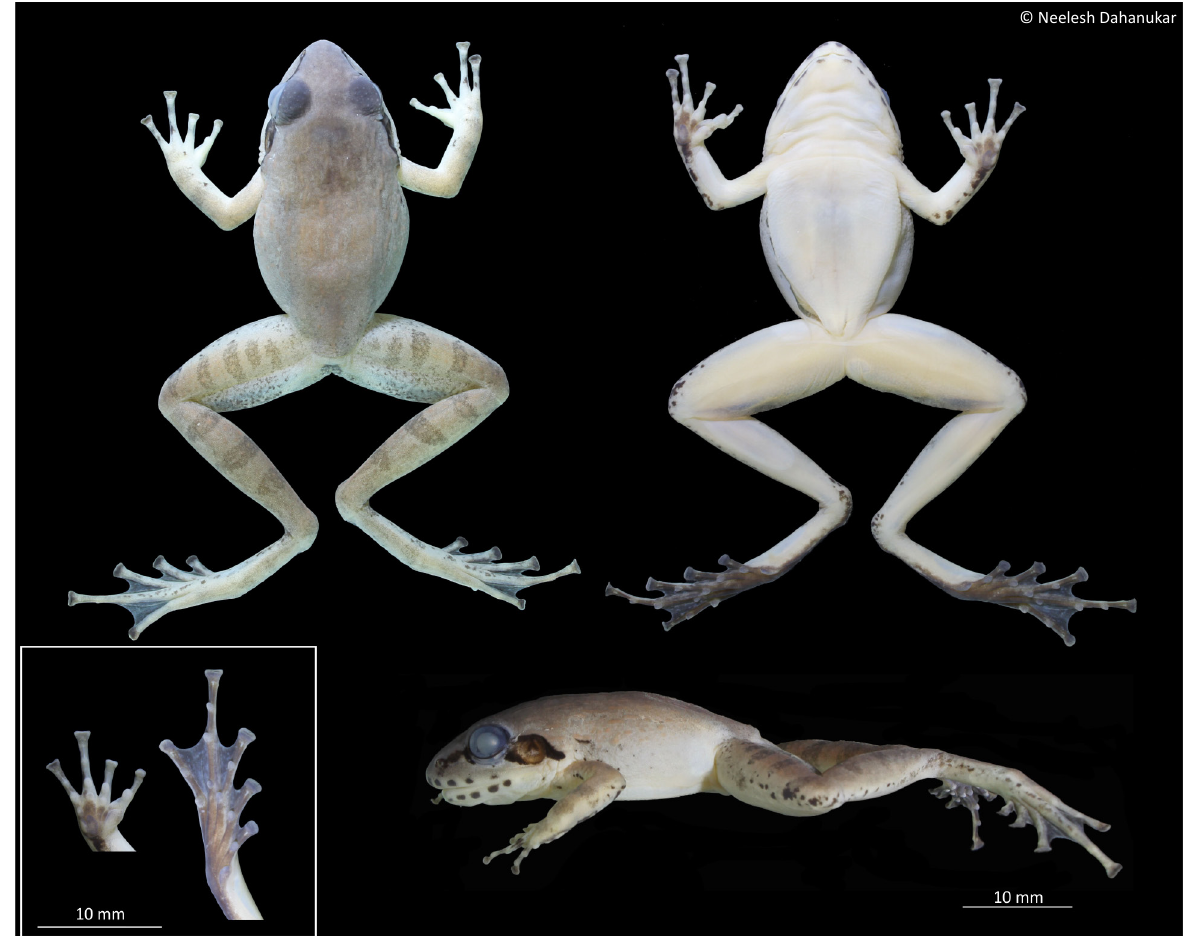
supernumerary tubercles absent; subarticular tubercles moderate; tarsal fold and outer phalangeal fringe absent; webbing formula I1-2II1-2½III1¼-3IV3-1¼V. Dorsal and ventral skin smooth; few longitudinal folds on dorsal side; lateral side granular. Description of Female (Paratype, BNHS 5933) (all measurements in